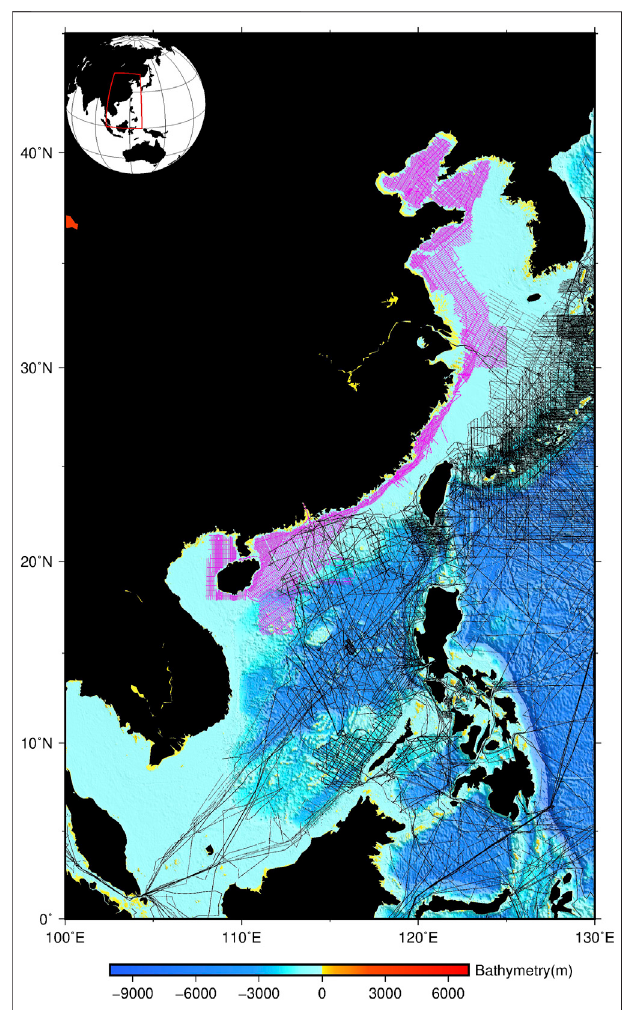
FIGURE 1 | Geographic distribution ofshipboard gravity measurements inthecoastalregionofChina.Themagentalinesarefromthe908Project,and the black lines are from the NCEI. The map was created by using GMT (http:// gmt.soest.hawaii.edu). The background bathymetric data is from GEBCO (https://download.gebco.net/); its spatial resolution is resampled to 1 ′ × 1 ′ .